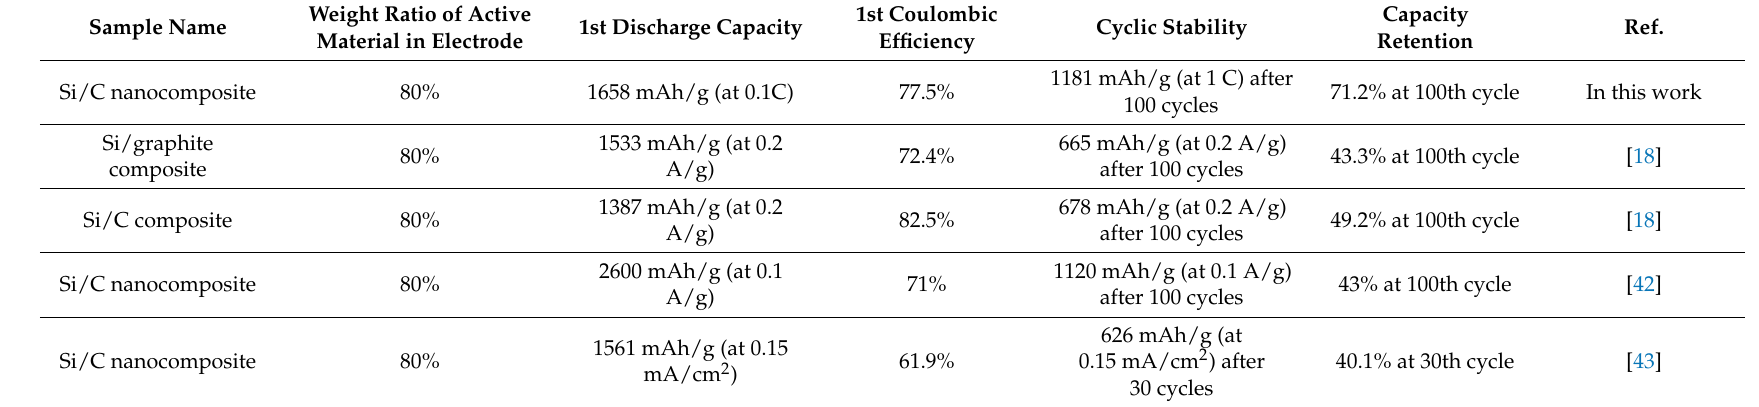
Table 2. Electrochemical performance of the Silicon/Carbon based anode materials for Li-ion secondary batteries (capacity retention for 100th cycle was calculated based on the first cycle reversible